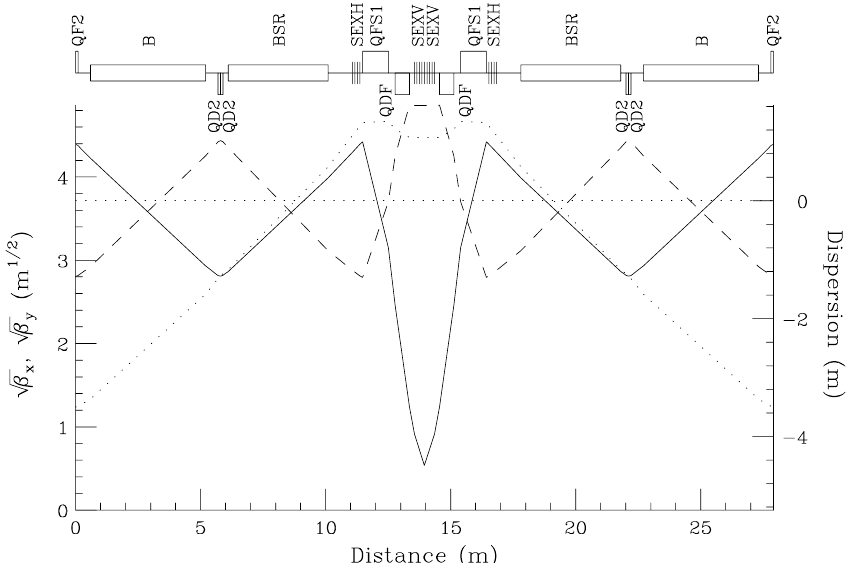
FIG. 49. Example (b): Lattice structure of the flexible momentum compaction module. b x (solid line), b y (dashed line), and dis- persion (dotted line). The maximum and minimum b x are 19.57 and 0.29 m, the maximum and minimum b y are 23.63 and 7.80 m, the maximum and minimum dispersions are 1.35 and 2 3.50 m. The natural horizontal and vertical chromaticities are 2 1.77 and 2 0.92 , giving a transition gamma of g t (cid:1) i 4.43 . The total module length is 27.91 m with a total bend angle of 0.917